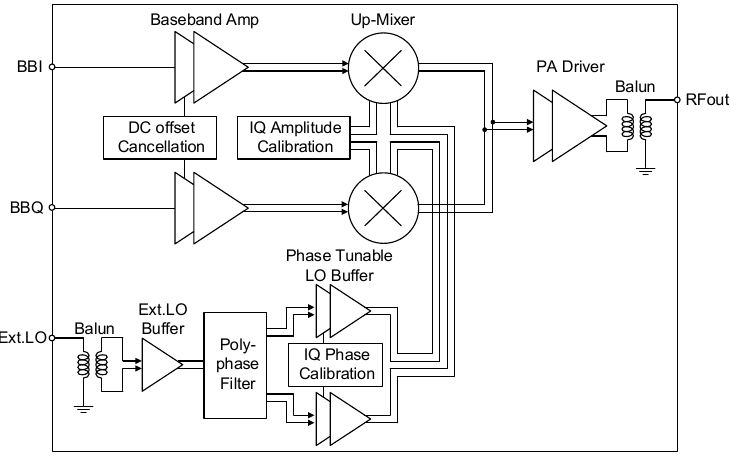
Figure 1. The 28 ‐ GHz direct ‐ conversion RF transmitter architecture. Figure 1. The 28-GHz direct-conversion RF transmitter